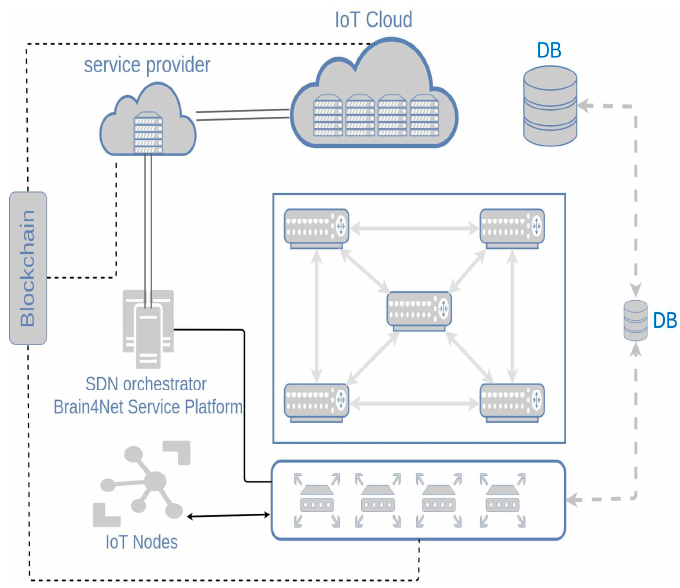
Figure 2. The system structure of the proposed IoT-Fog system with Software Designed Networking (SDN)/blockchain.